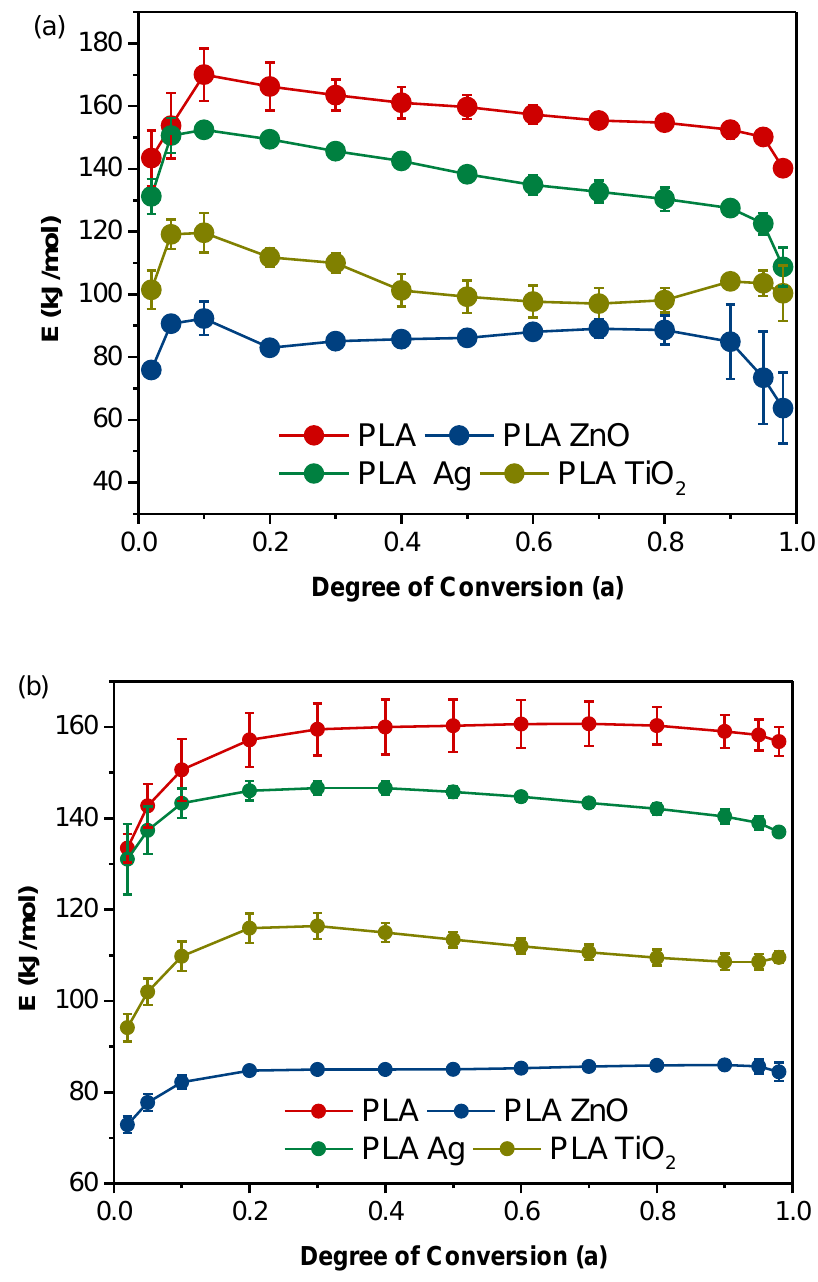
Figure 8. Calculated activation energy (E) for the thermal degradation of neat PLA and its nanocomposites by using ( a ) the Friedman method, and ( b ) the Ozawa, Flynn, and Wall analysis.